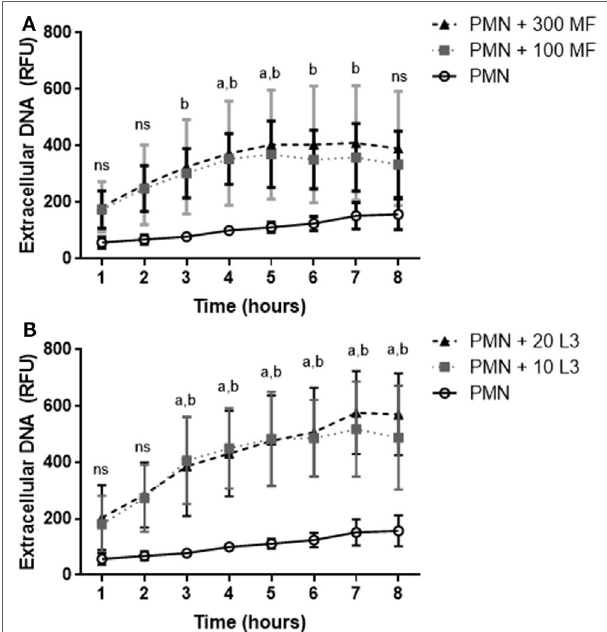
FigUre 4 | Time dependency of Dirofilaria immitis -induced neutrophil extracellular traps. Canine polymorphonuclear neutrophils (PMN) were cocultured with microfilariae (a) or L3 (B) for 8 h. Sytox Orange-positive signals were analyzed every hour by spectrofluorometric analysis using an automated plate monochrome reader. (a) a: significant difference between PMN and 100 microfilariae; b: significant difference between PMN and 300 microfilariae. (B) a: significant difference between PMN and 10 L3; b: significant difference PMN and 20 L3. Abbreviation: ns, not